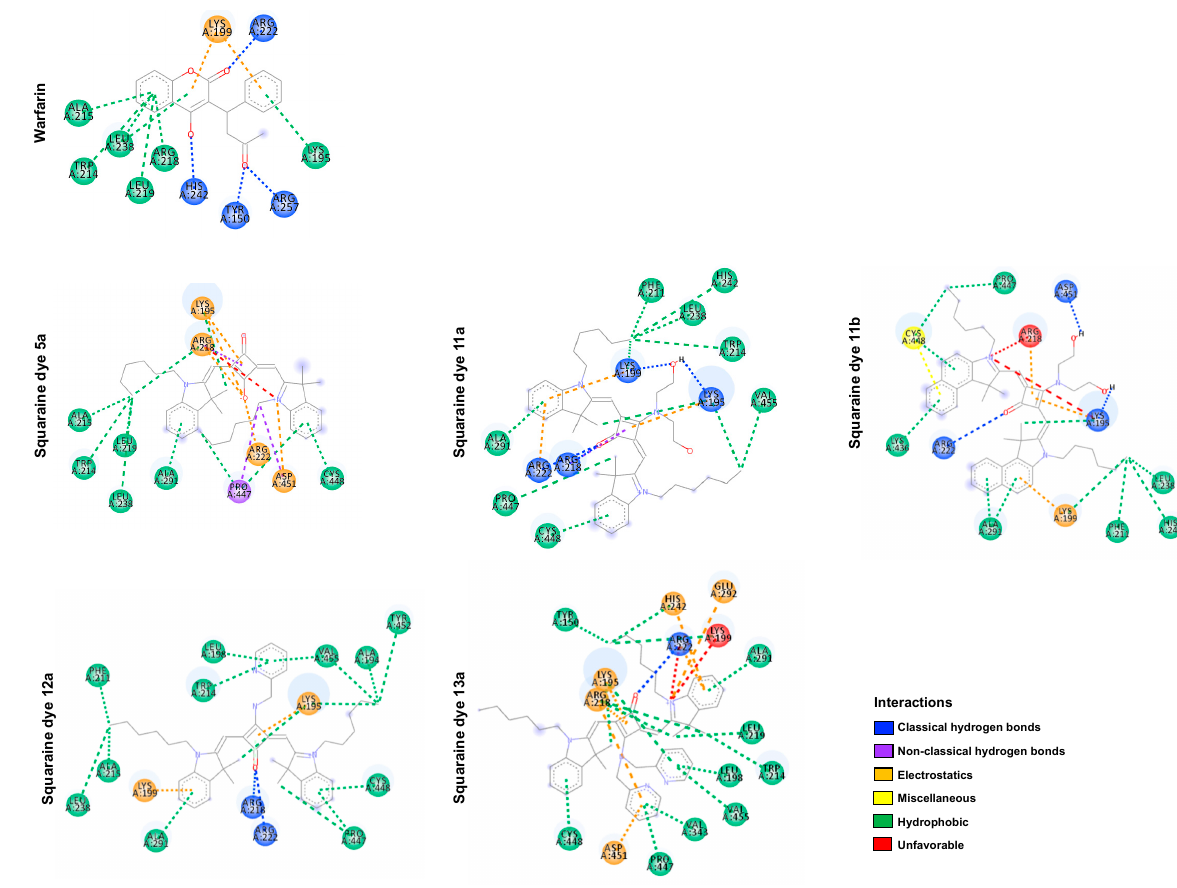
Figure 4. Binding modes and interactions of warfarin and squaraine dyes 5a , 11a , b , 12a , and 13a with amino acid residues of human serum albumin protein at Sudlow site I.